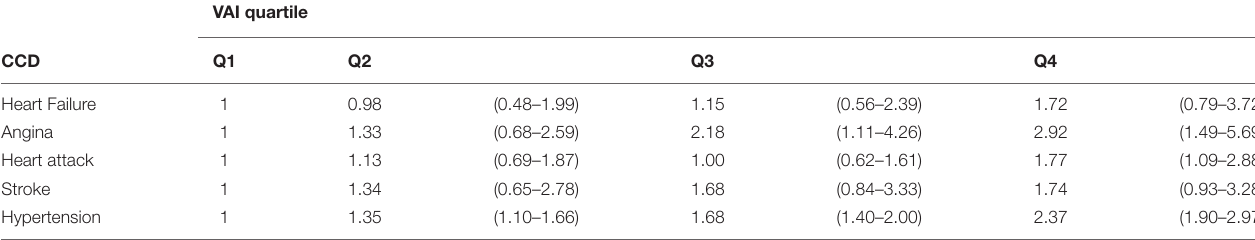
TABLE 4 | Weighted logistic model for the association of VAI quartiles with CCDs in NHANES (1999–2018). VAI